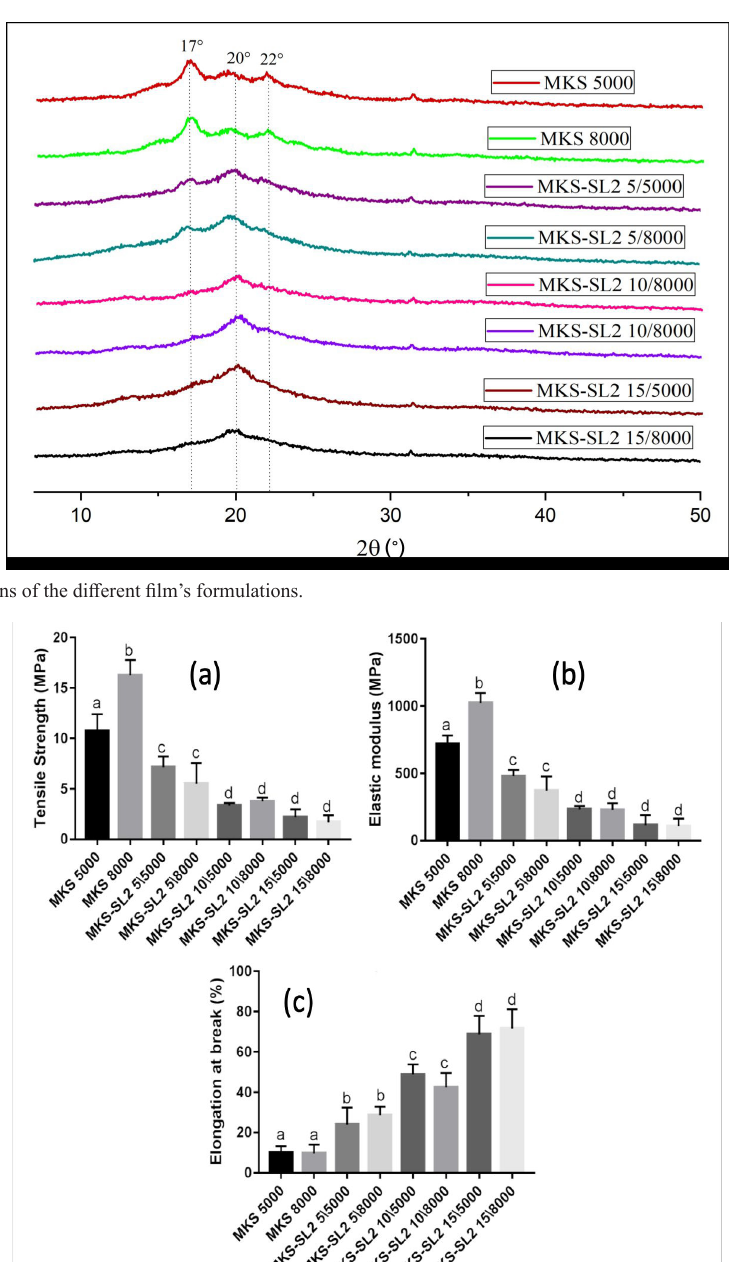
Figure 6. (a) tensile strength, (b) elastic modulus and (c) elongation at break of the films. Values sharing a common letter are not significantly different (p <